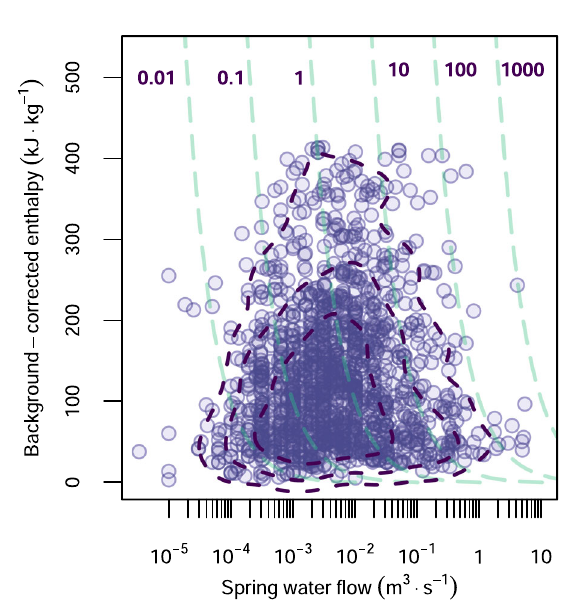
Fig. 5 | Background-corrected enthalpy vs spring water discharge rate. Rela- tionship between background-corrected saturated liquid enthalpy and spring water discharge obtained in this work. The turquoise dashed isolines represent different values of discharged heat in MW. The dark purple dashed lines enclose 95%, 80% and 50% of the reported thermal